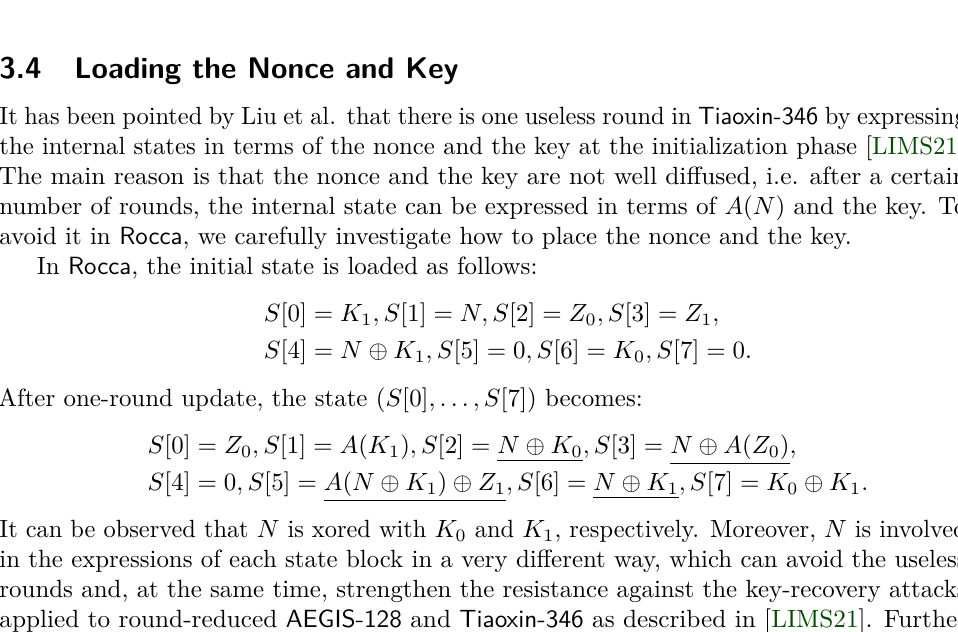
Table 5: Speed (in cycles / Byte) of round functions of Rocca , AEGIS-128 , AEGIS-128L , AEGIS-256 , Tiaxion-346, and JN16 (not include a generation part of a ciphertext). Primitive Speed (in cycles / Byte) # of blocks rate AEGIS-128 0.384482 5 5 AEGIS-256 0.388125 6 6 AEGIS-128L 0.191072 8 4 Tiaoxin-346 0.192413 13 3 [JN16] 0.140433 12 2 Rocca 0.124609 8